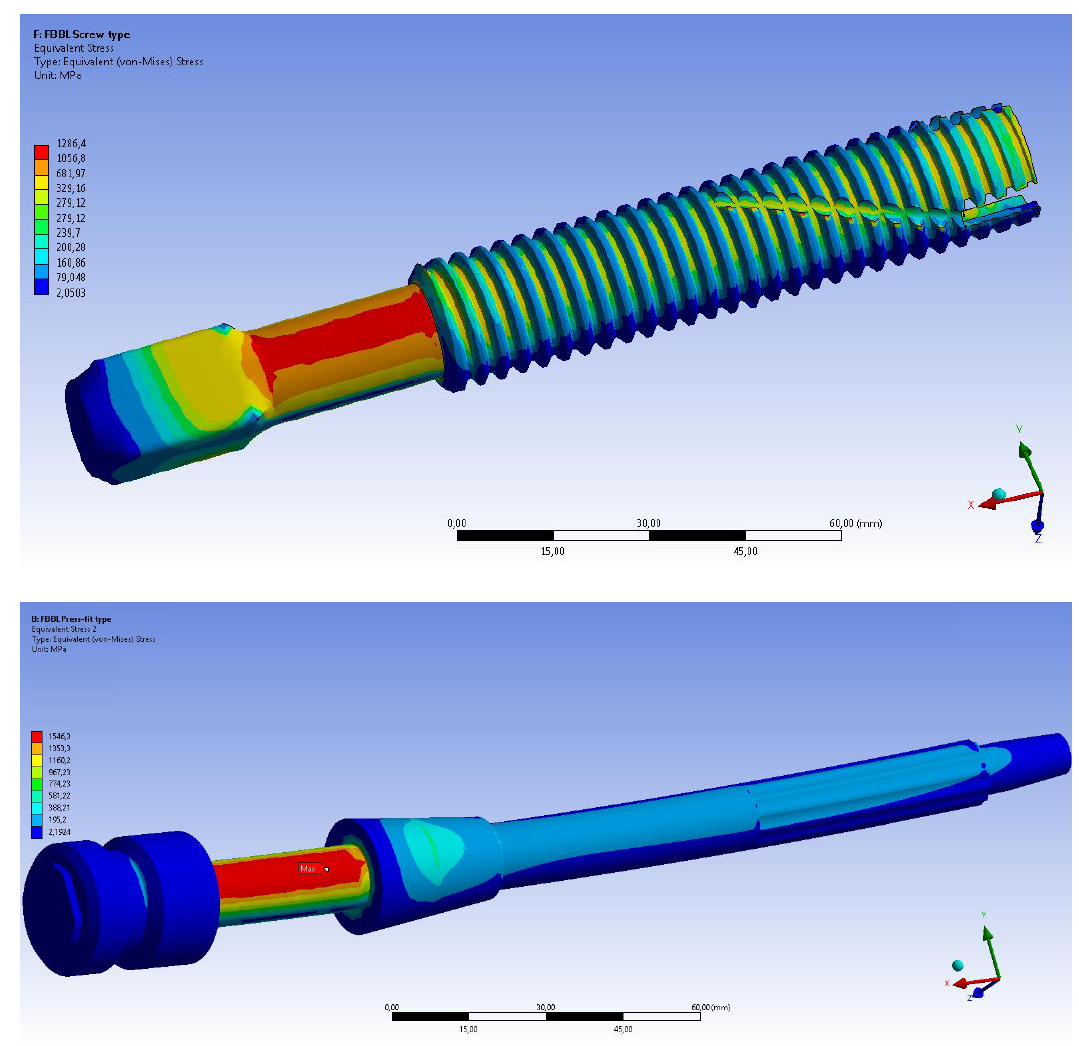
Figure 10. Fall Backwards with Balance Loss (FB BL) scenario: von Mises stress distribution on the OPRA ( top ) and the OPL ( bottom ) prosthesis